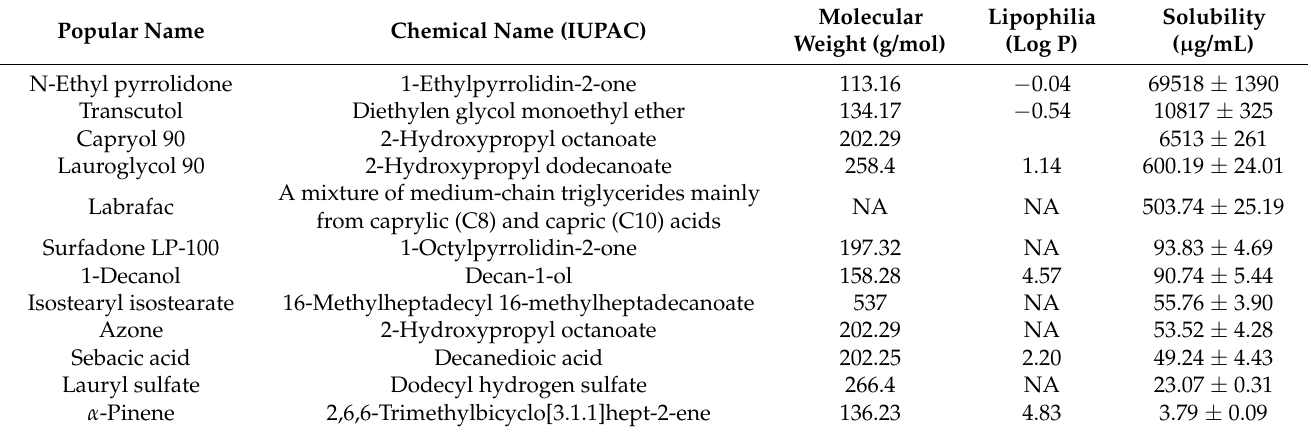
Table 2. Molecular weight, lipophilia, and estimated solubility of BCT in different oils and enhancers by absorption spectroscopy. Results are reported from the highest to the lower solubility of BCT in the solvents.